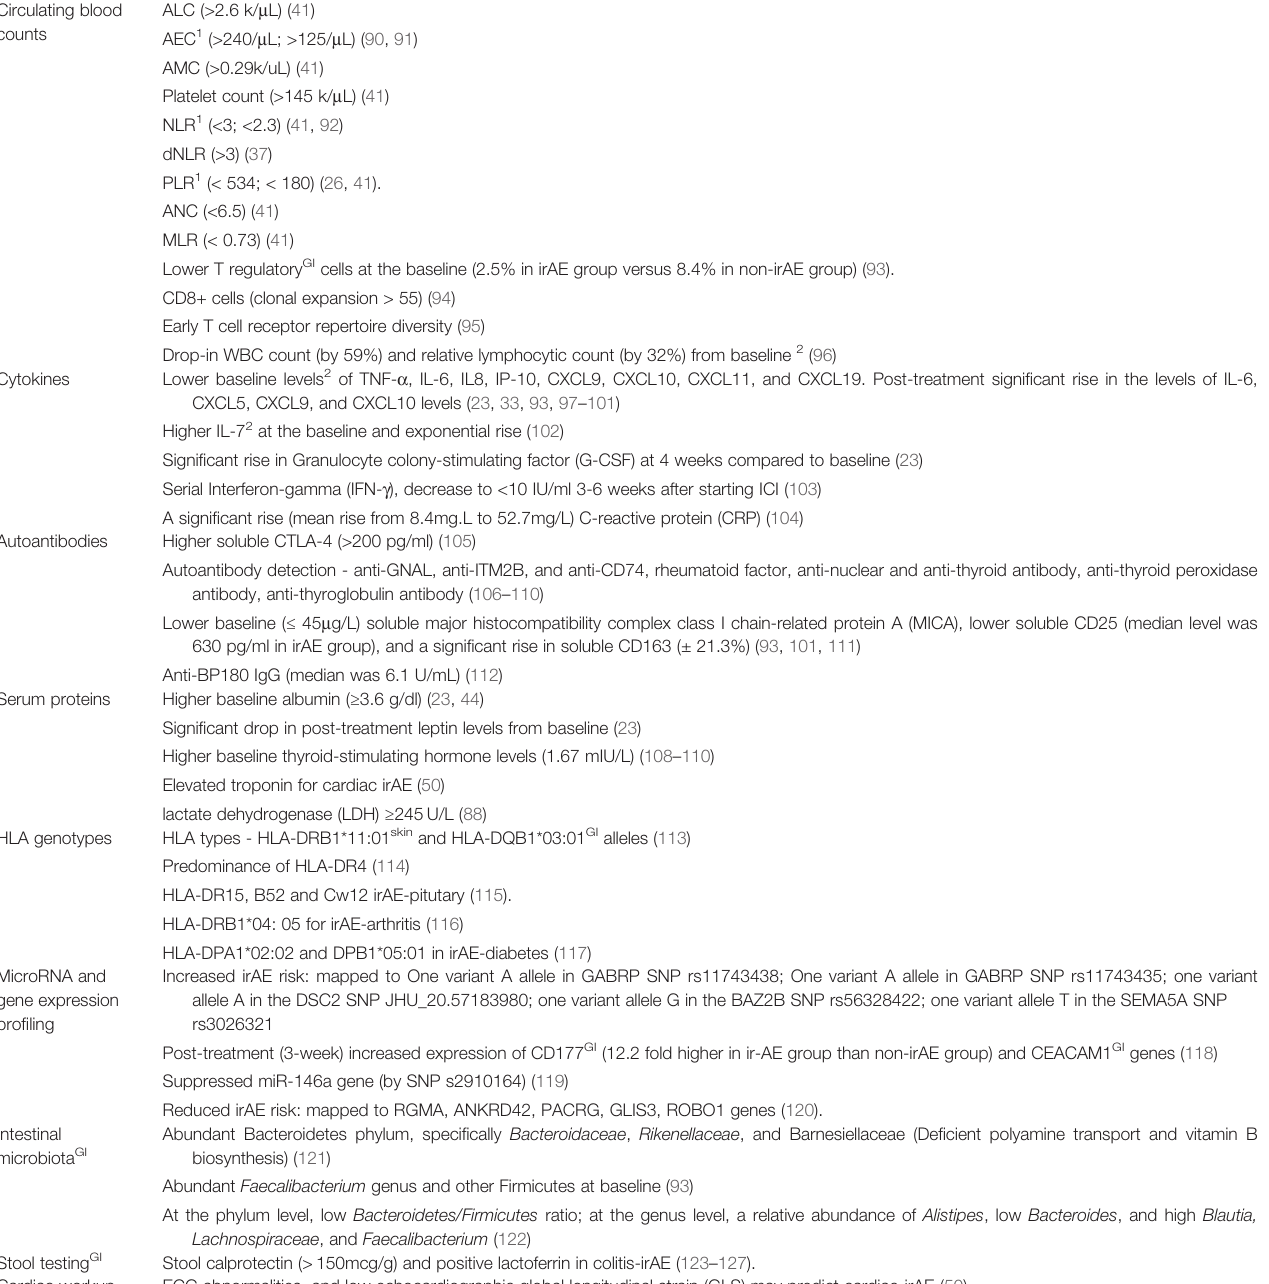
TABLE 2 | Biomarkers for predicting immune-related adverse